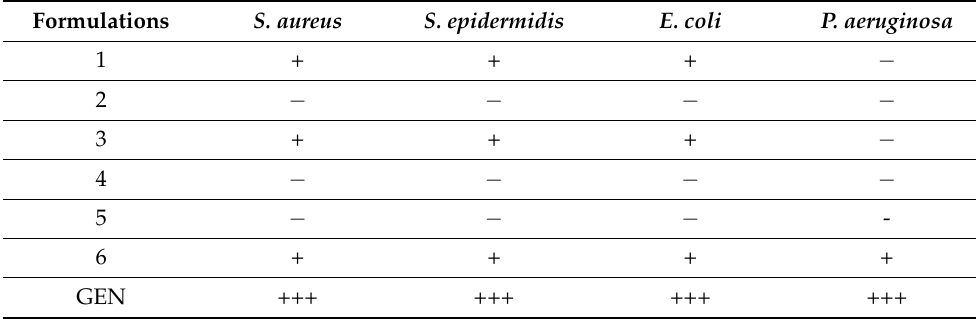
Table 5. Schematic results of disk diffusion